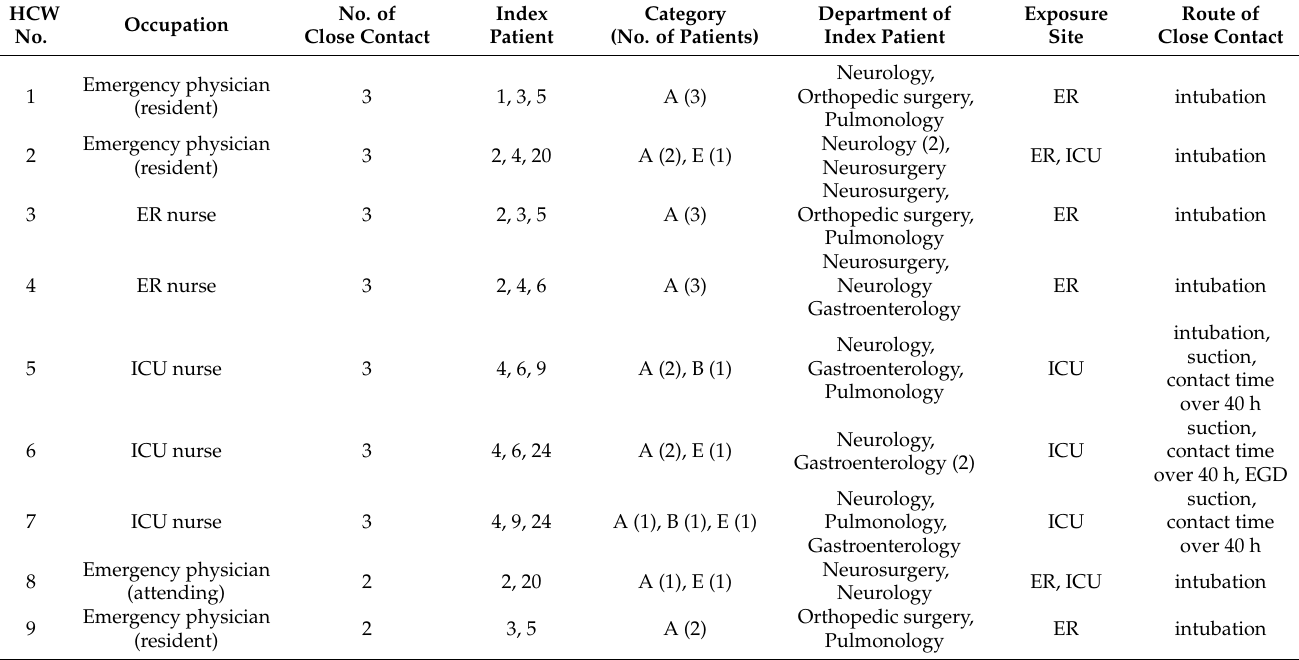
Table 2. Healthcare workers with multiple